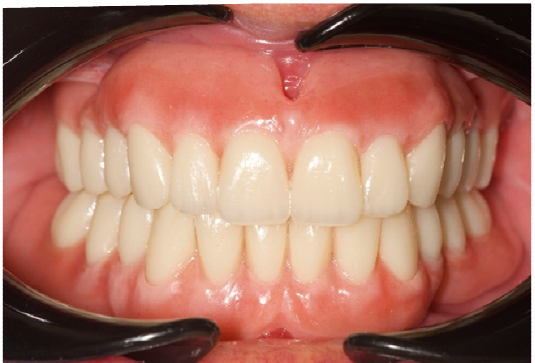
Figure 3. New complete removable dentures, based on the diagnostic